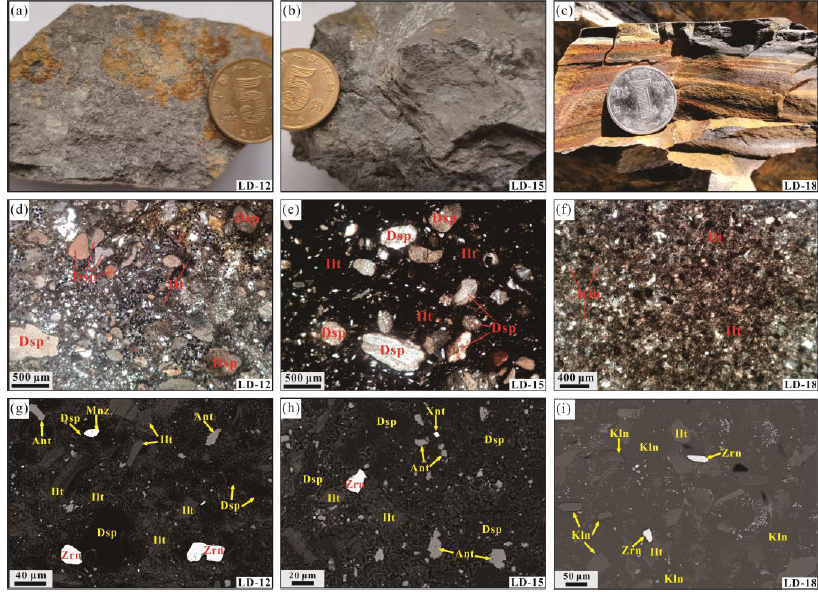
Figure 4. Hand-specimen, microscopical, and SEM backscattered electron (BSE) photographs of the representative bauxite ore and bauxitic claystone samples of the Lindai bauxite deposit. ( a ) Gray clastic bauxite ore of the LD-12 sample (modified from [28]). ( b ) Gray compact bauxite ore of the LD-15 sample. ( c ) Gray black laminated bauxitic claystone of the LD-18 sample (modified from [28]). ( d ) Matrix-supported clastic texture in the LD-12 sample (plane-polarized light). ( e ) Matrix-sup- ported pisolitic texture in the LD-15 sample (plane-polarized light). ( f ) Pelitomorphic texture in the LD-18 sample (cross-polarized light). ( g ) Diaspore, illite, anatase, zircon, and monazite in the LD-12 sample. ( h ) Diaspore, illite, anatase, zircon, and xenotime in the LD-15 sample. ( i ) Granular kaolin-